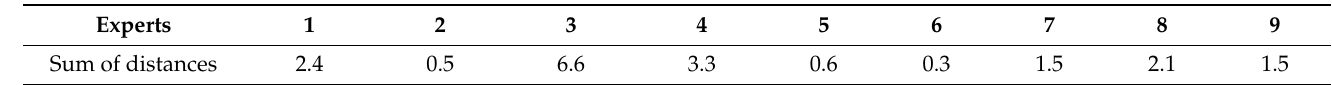
Table 6. Kemeny median between one expert’s opinions in relation to the others in the case of the deviations of one expert’s opinions.